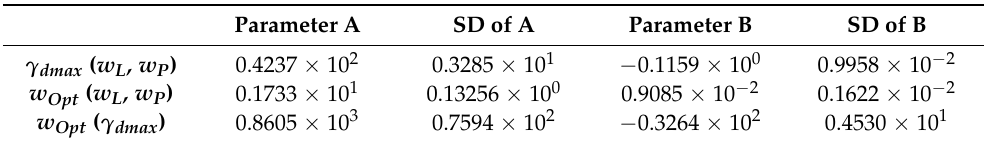
Table 3. Parameters A and B and their uncertainties (Parameters A and B correspond respectively to the first and second constant in Equations